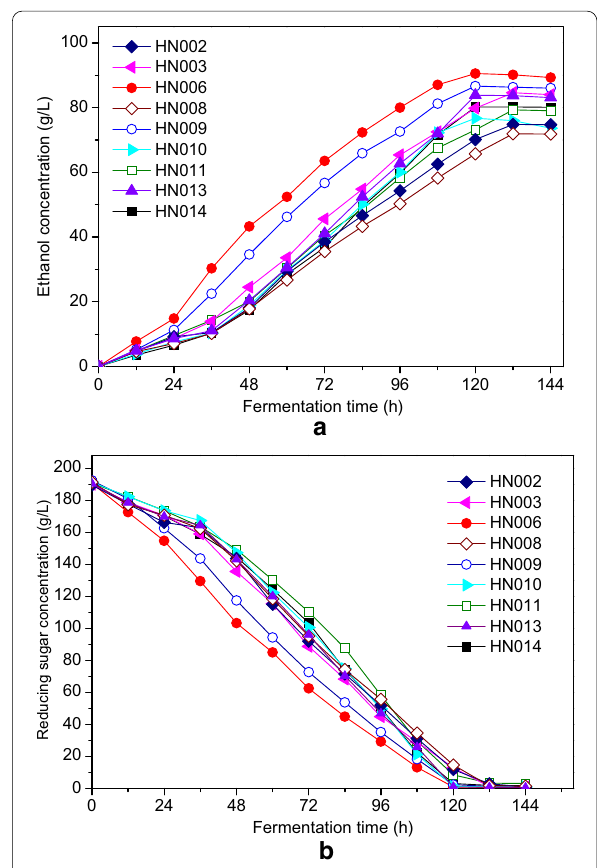
Fig. 3 Fermentation profiles of Chinese chestnut wine with various yeast strains: a ethanol; b reducing sugar